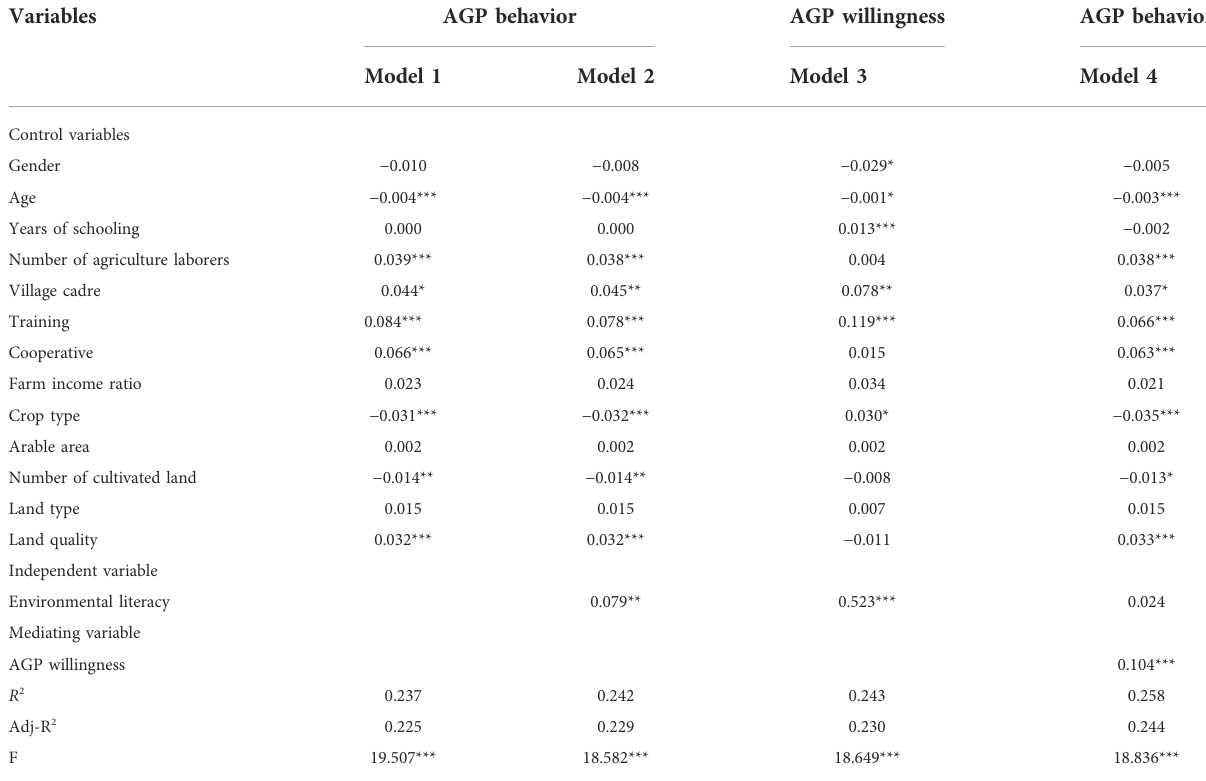
TABLE 9 The mediation effect of AGP willingness (Causal step regression).